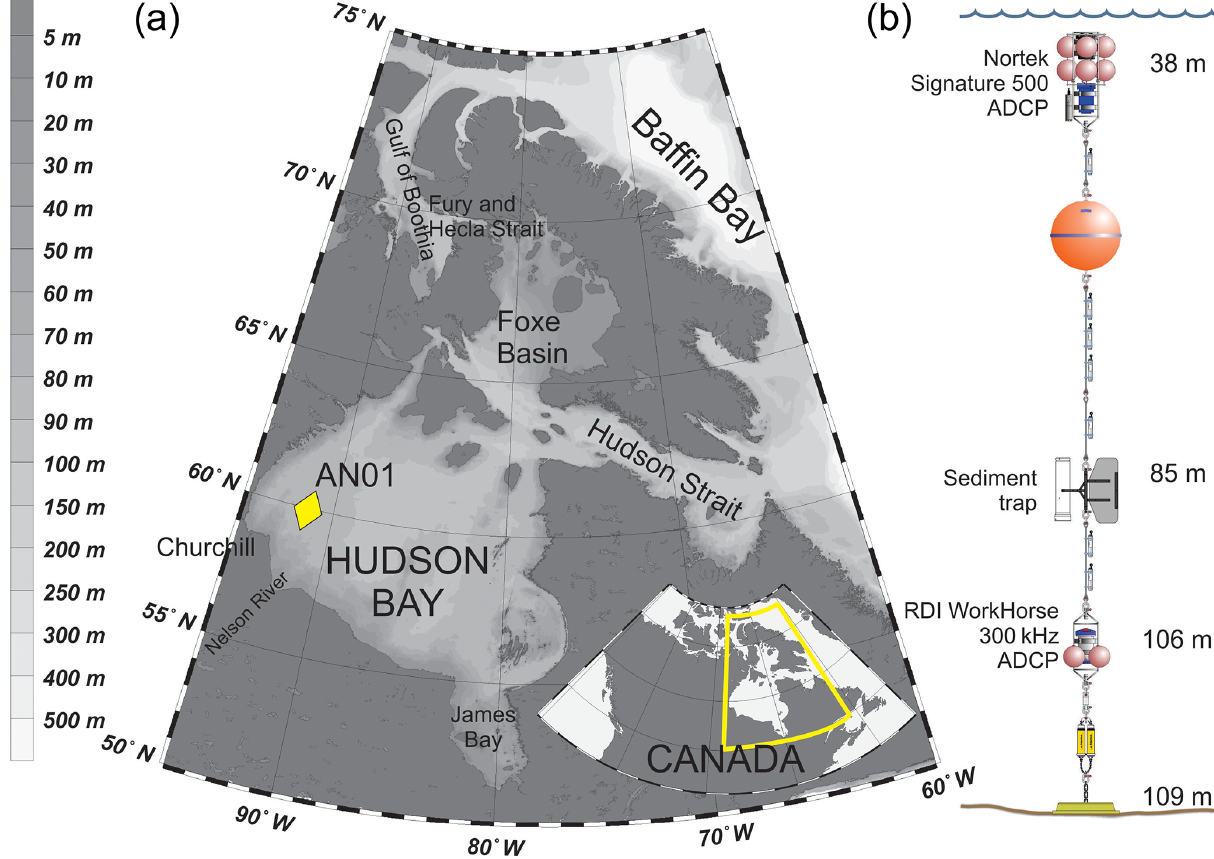
Figure 1. (a) A bathymetric map of the Hudson Bay region and the location of the mooring (AN01). The inset map shows Hudson Bay on a map of Canada. (b) Schematic illustration of the mooring AN01